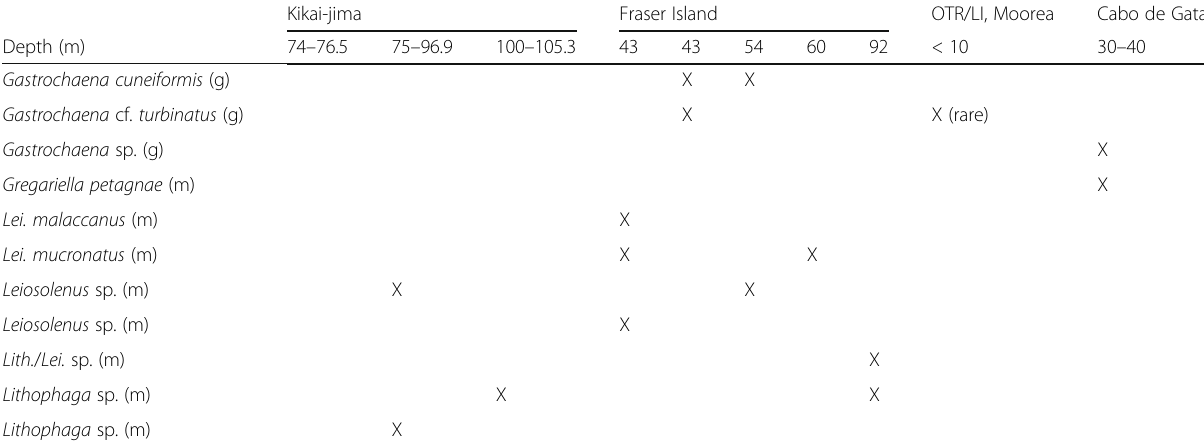
Table 2 Distribution of the identified gastrochaenid (g, Gastrochaenidae) and mytilid (m, Mytilidae) bivalve taxa in the studied macroid and rhodolith